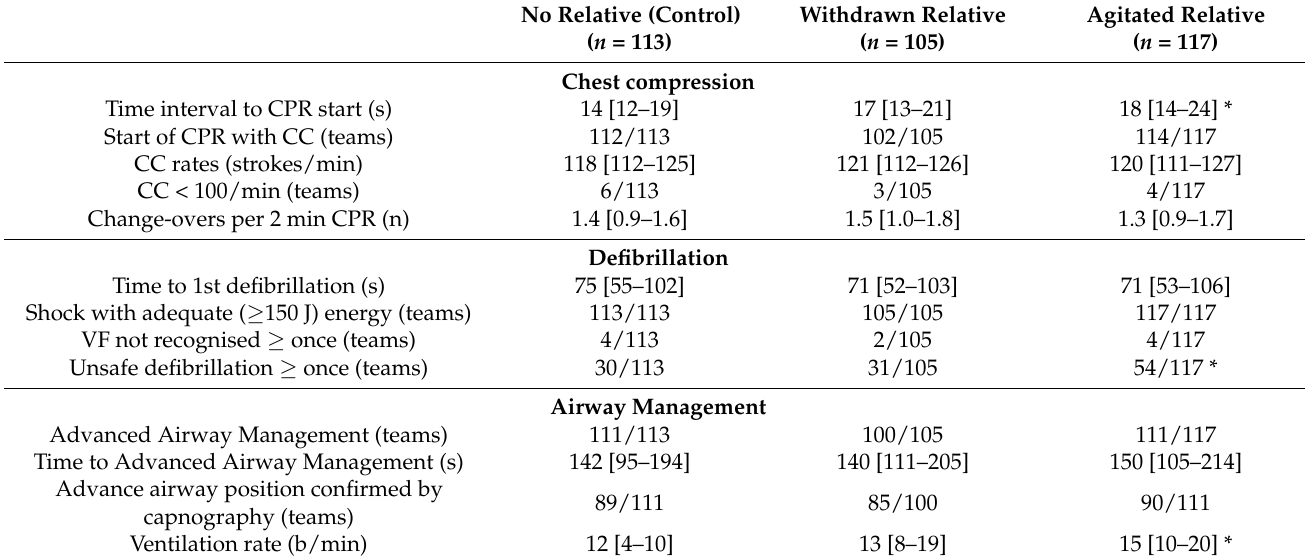
Table 1. Secondary outcome parameters.